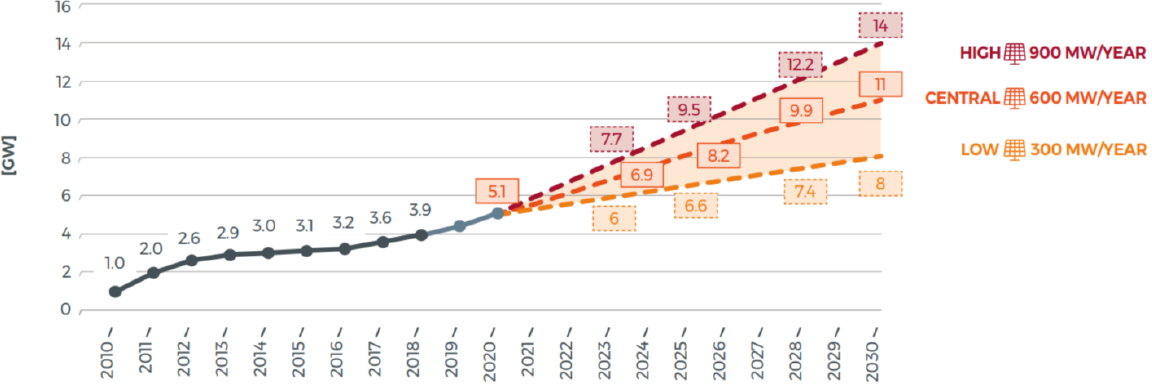
Figure 25. Historical and predicted values of solar PV installed capacity in Belgium [153].